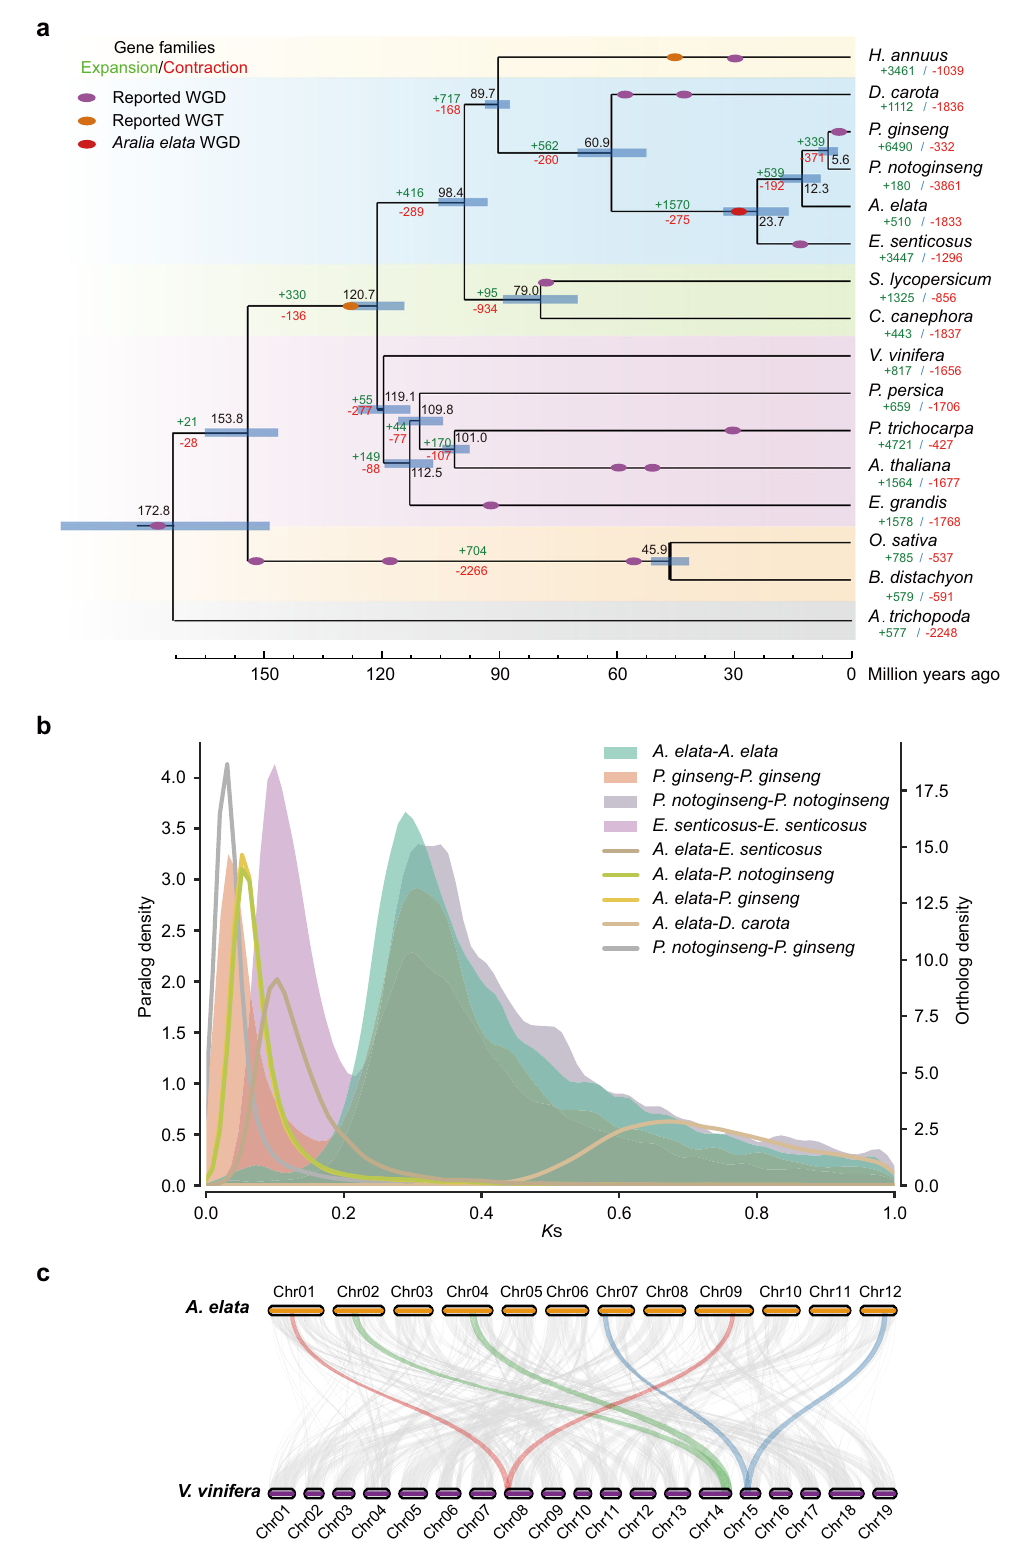
Fig. 2 Genome evolution of A. elata . a Inferred phylogenetic tree. Gene family expansions are indicated in green, and gene family contractions are indicated in red. The timings of whole-genome duplication (WGD) and whole-genome triplication (WGT) events are superimposed on the tree. Divergence times were estimated by MCMCTree, and the blue bars show the 95% con fi dence intervals of divergence times in millions of years. The black numbers near the nodes indicate the median divergence times. b Distributions of synonymous substitutions per synonymous site ( K s) of one-to-one orthologs identi fi ed between A. elata , P. ginseng , D. carota , E. senticosus , and P. notoginseng . c Syntenic plots show a 2:1 syntenic relationship between the A. elata genome and V. vinifera